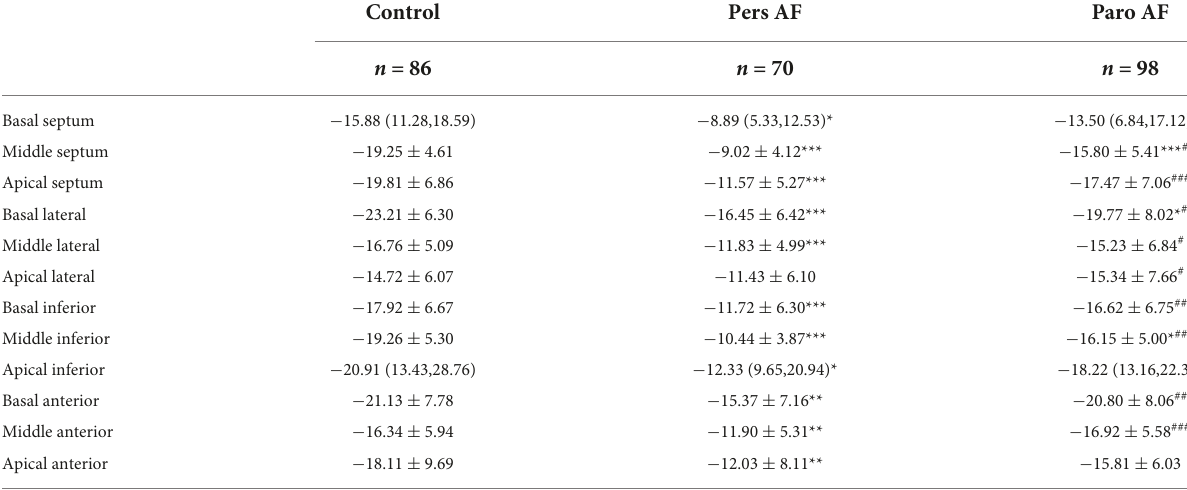
TABLE 3 Comparison of regional longitudinal strain (%) among subjects with different types of AF.